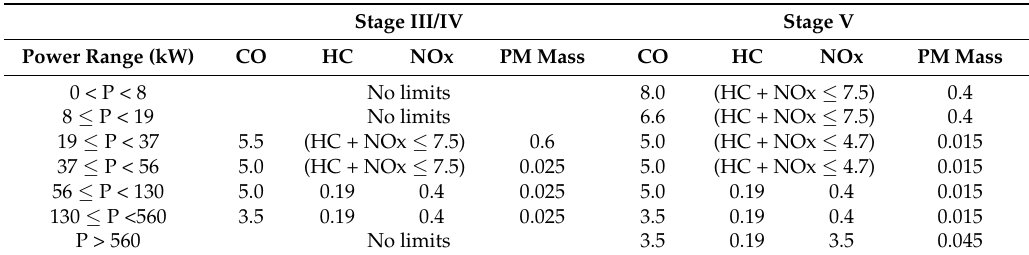
Table 1. European emission limits for CI engines of NRMM